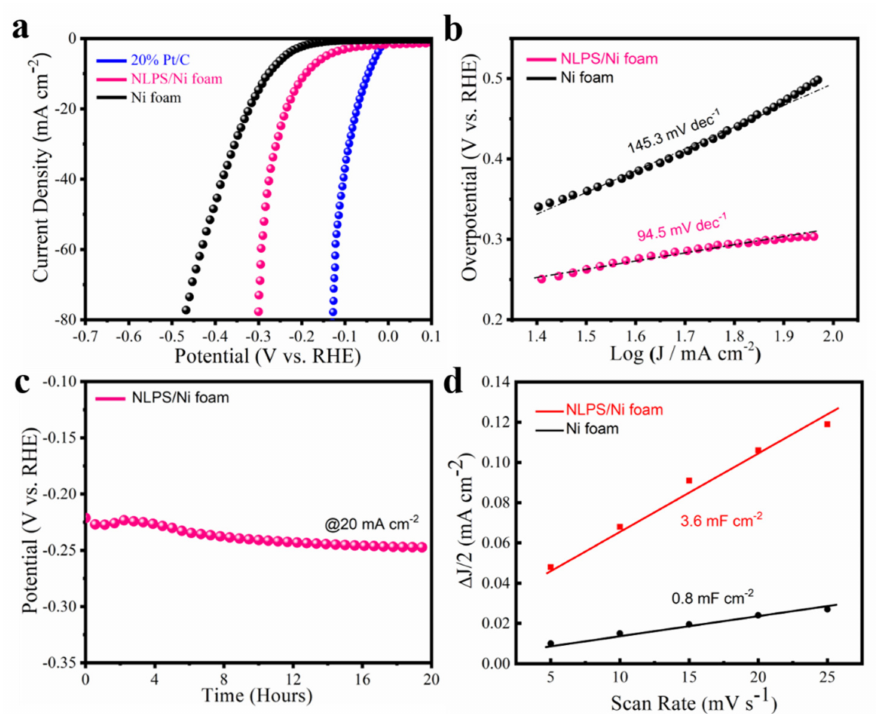
Figure 5. HER electrocatalytic performance in alkaline media. ( a ) Polarization LSV curves and ( b ) Tafel plots of NLPS/Ni foam and Ni foam; ( c ) durability test of NLPS/Ni foam at − 20 mA cm − 2 ; ( d ) linear plot of ∆ j vs. scan rate of NLPS/Ni